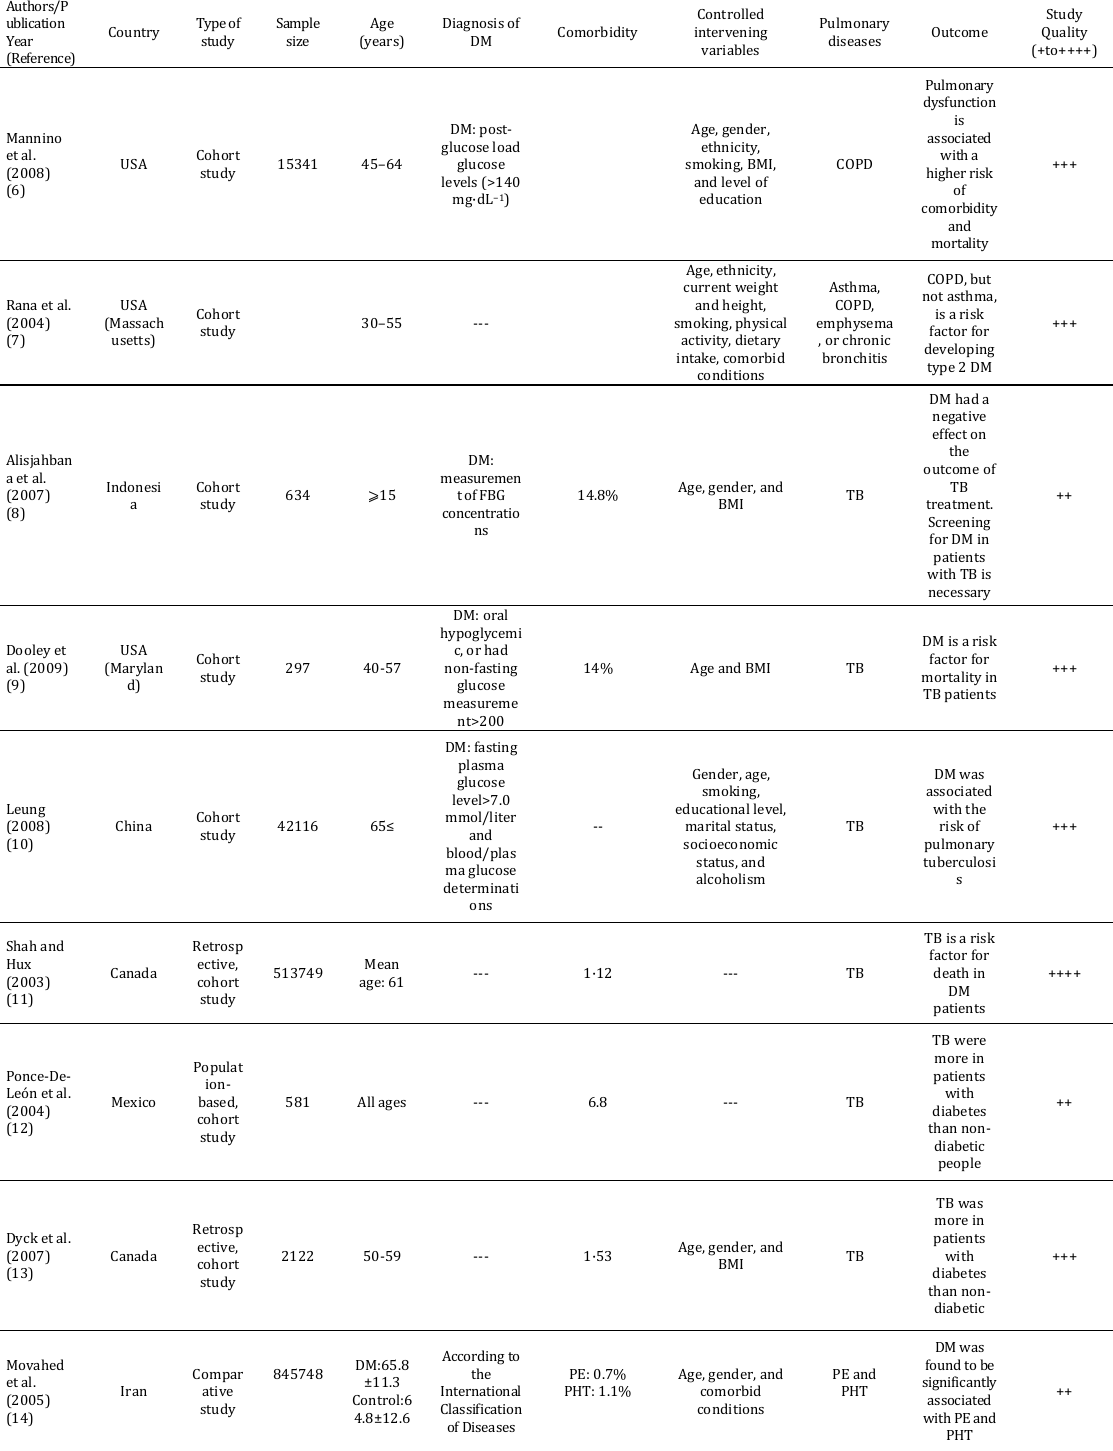
Table 1. Evaluation of some variables associated with pulmonary diseases concomitant with diabetes based on the literature review